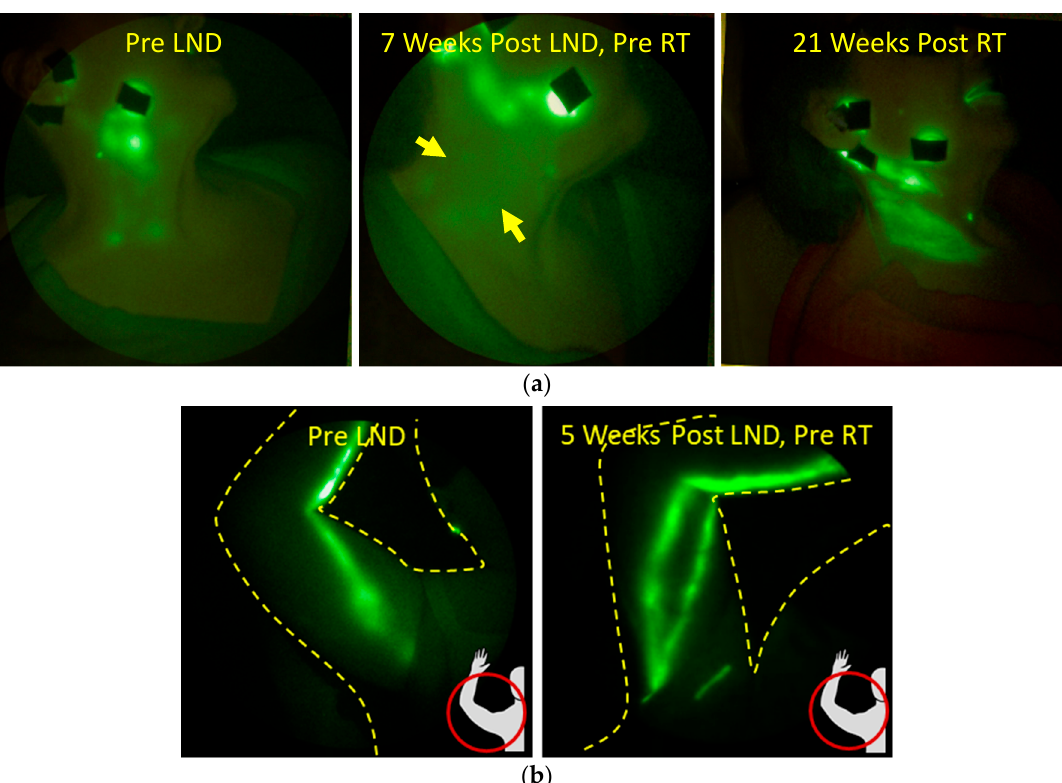
Figure 8. Examples of normal and abnormal lymphatic recovery following LN dissection and radiation treatment (RT). ( a ) NIRF-LI images overlaid on color images showing the case of a head and neck cancer patient who had 19 nodes surgically removed. Approximately seven weeks post-surgery, no dermal backflow was visible and two lymphatic vessels (arrows) with active lymphatic propulsion were faintly visible. Dermal backflow was observed when next imaged approximately 21 weeks after the completion of RT (adapted from [29], Rasmussen, JC, et al., 2017). ( b ) The case of a neo-adjuvant, advanced breast cancer patient before and after LN dissection with no RT. Injection sites are covered with round bandages and / or black vinyl tape. The brightness and contrast of the images have been adjusted to facilitate the visualization of the 16-bit imaging depth.